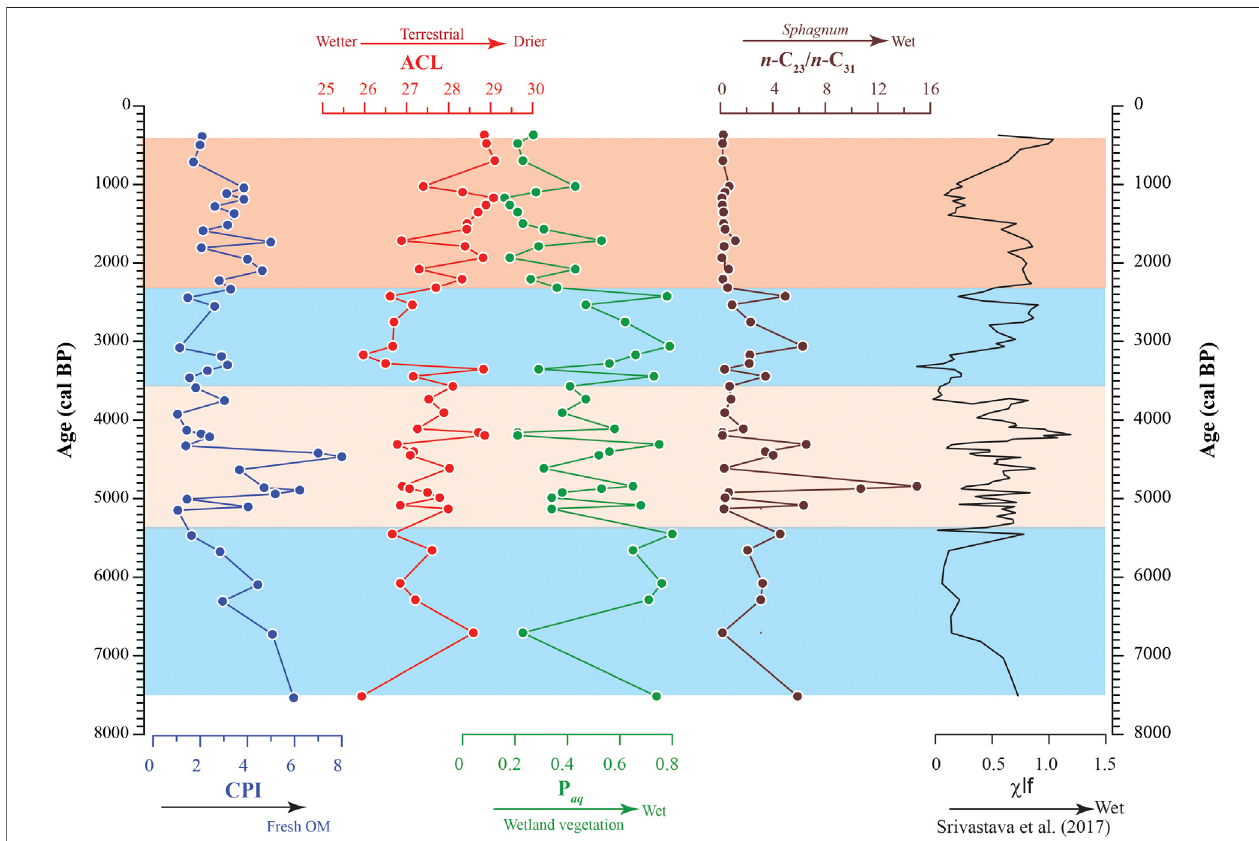
FIGURE 4 | The temporal variation of the CPI, ACL, P aq and n -C 23 / n -C 31 across the studied ∼ 8000 cal yr BP sedimentary succession. The P aq and n -C 23 / n -C 31 re fl ect thein fl ux ofwetlandvegetation and ACLindicates wetter or drierhydrological conditions. Thepalaeohydrological reconstruction bySrivastava et al.(2017) based on multiproxy records has been incorporated on the right representing the changing dry and wet phases across the studied succession as deduced from the previous work.